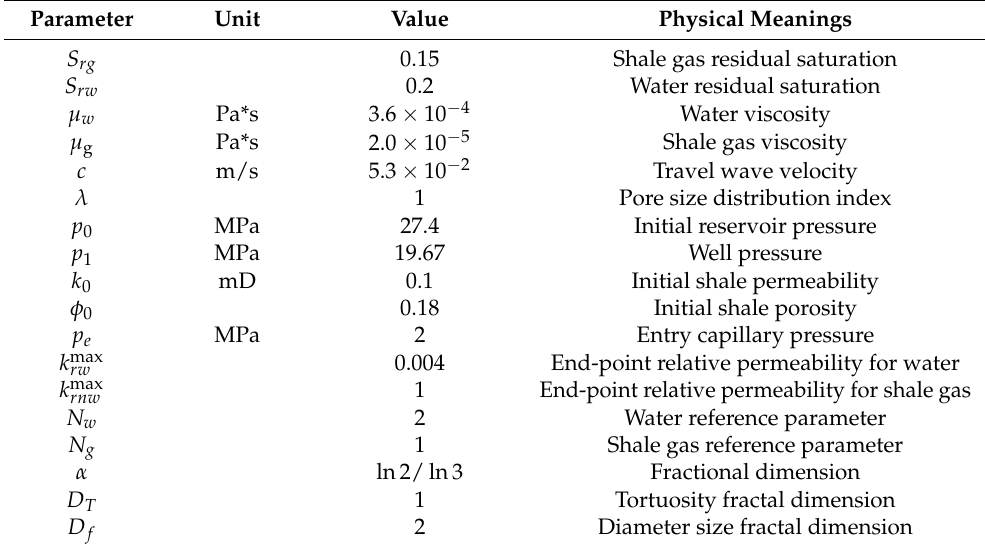
Table 1. Computation parameters from a shale gas reservoir in China.